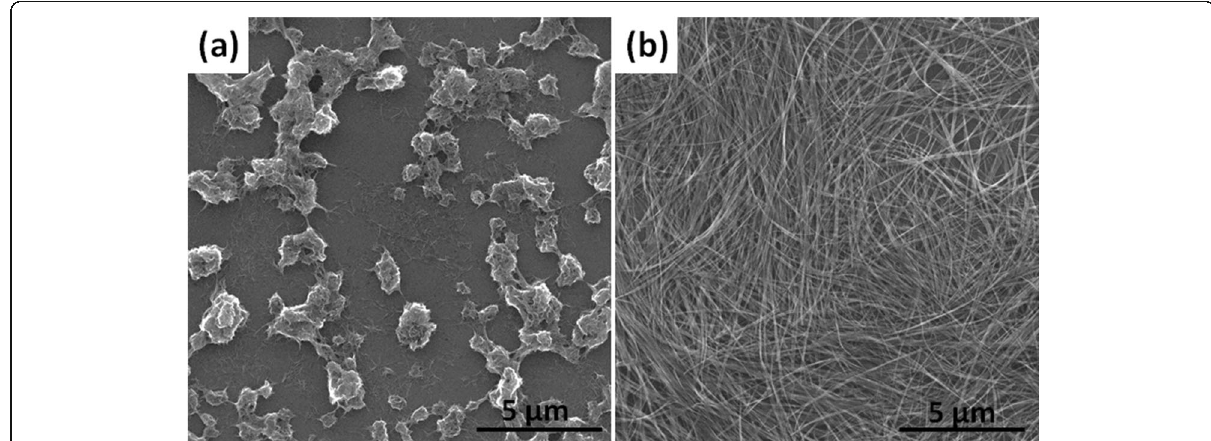
Fig. 2 SEM images of Na 2 Ti 3 O 7 nanotubes synthesized by hydrothermal method with 0 rpm ( a ) and 300 rpm ( b